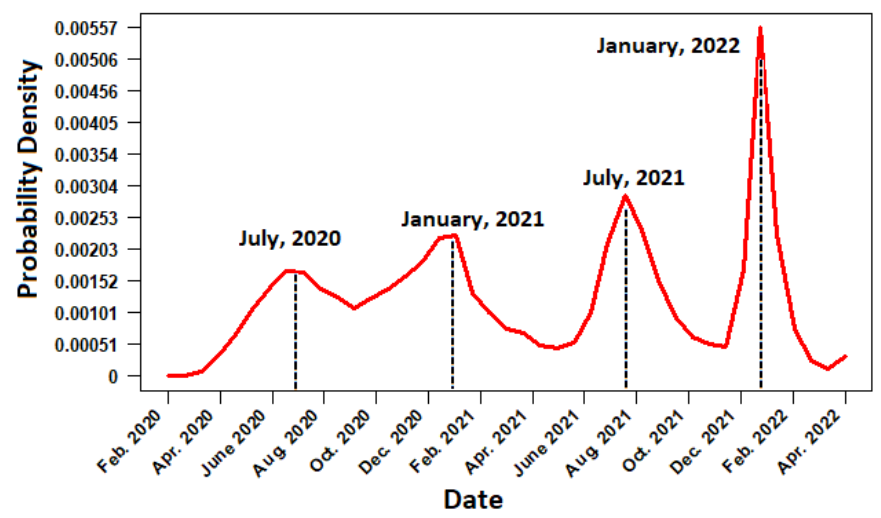
Figure 1. Temporal distribution function in terms of probability for daily COVID-19 cases from February 2022 to April 2021. The dotted line represents the date when a maximum was reached in COVID cases.